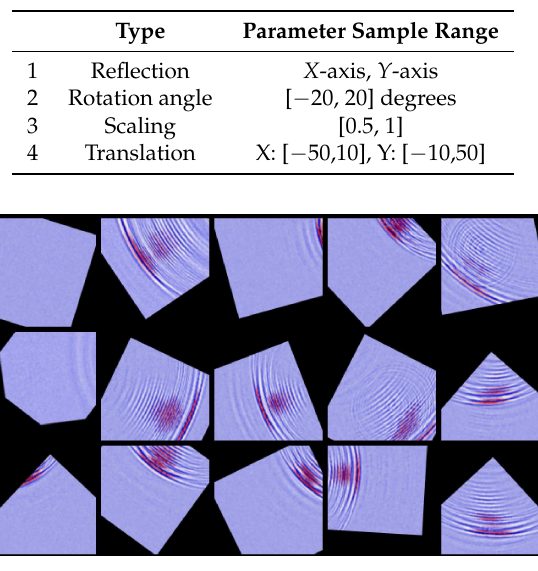
Figure 8. Sample patches from